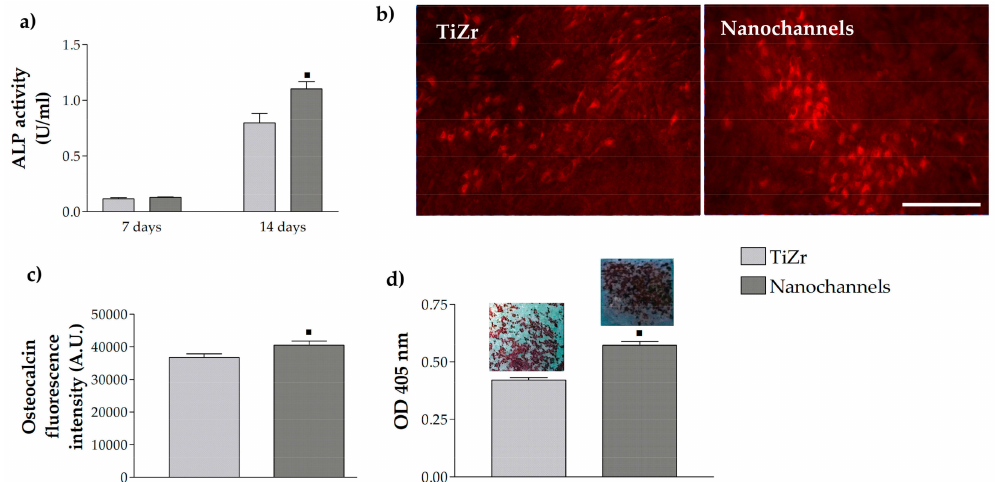
Figure 6. Differentiation of MC3T3-E1 pre-osteoblasts grown on the analyzed samples. ( a ) The expression levels of intracellular alkaline phosphatase (ALP) activity at 7 and 14 days post-seeding; ( b ) immunofluorescence detection of osteocalcin expression by MC3T3-E1 cells grown for 3 weeks on tested samples. Scale bar represents 200 µ m. ( c ) Quantification of osteocalcin intensity using ImageJ; ( d ) quantitative colorimetric analysis of extracellular matrix mineralization after 3 weeks of culture and the staining pictures. Results are presented as means ± SEM ( n = 3); p < 0.05 vs.